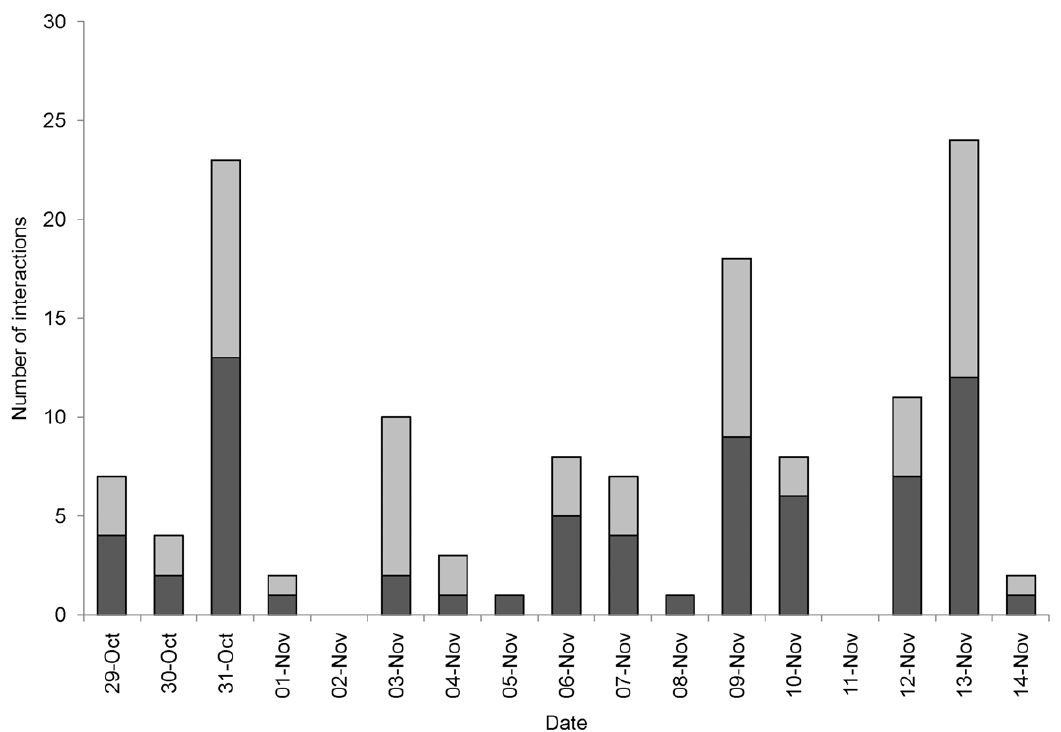
Figure 3. Shark interactions. Daily total number of interactions for shark 365, recorded from ARX receiver # 5. Dark grey bars represent interactions lasting , 30 seconds, and light grey bars denote interactions lasting $ 60 seconds.